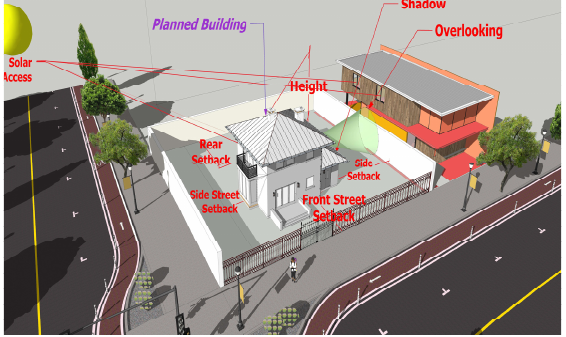
Figure 1. Examples of land-use regulations (in RED colour) for a new proposed (planned) building (left building in the